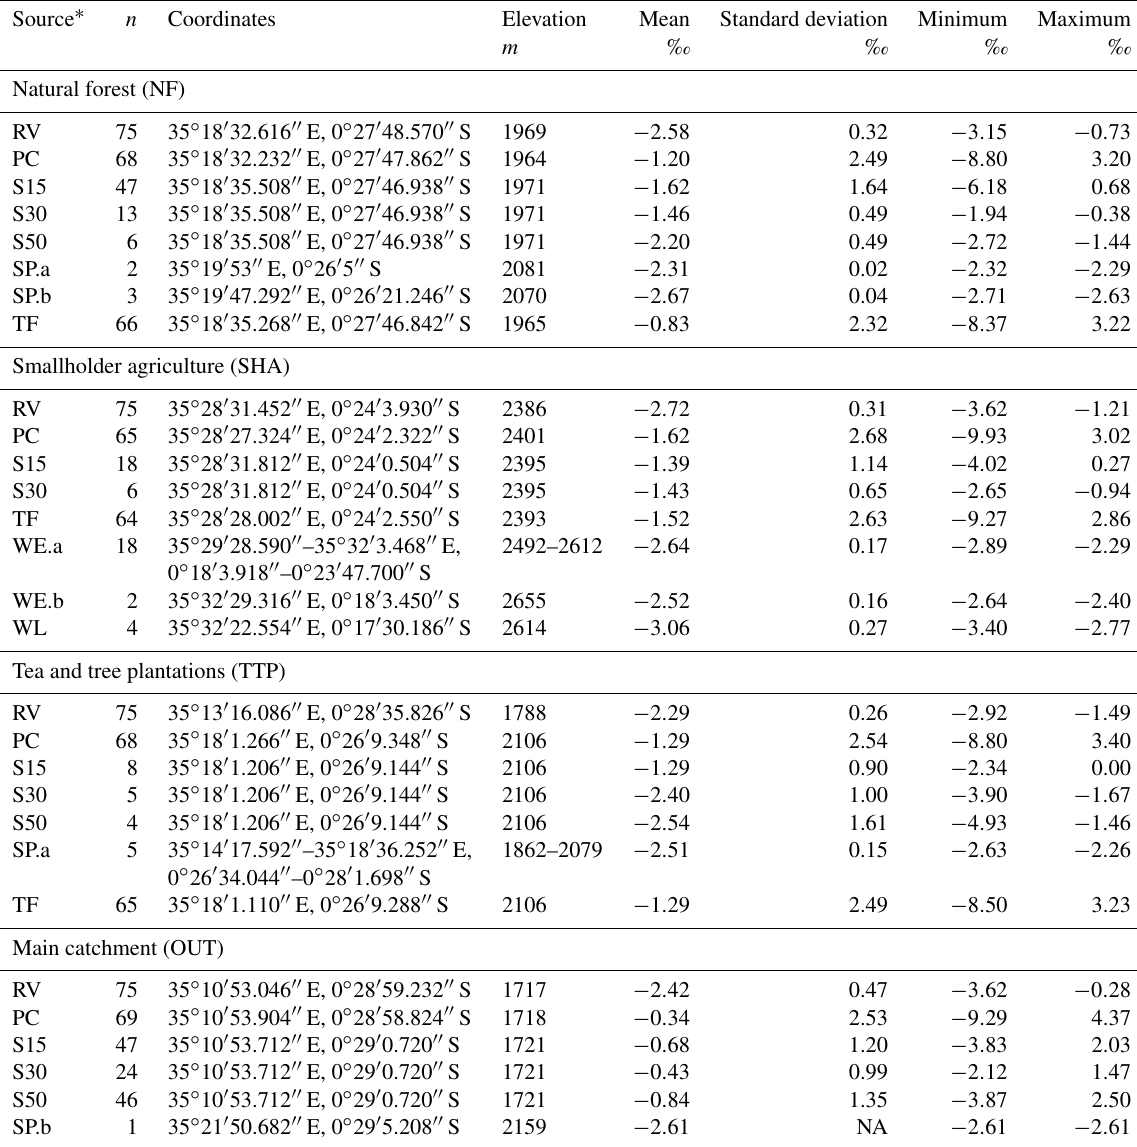
Table 4. Number of samples ( n ), coordinates, elevation, and summary statistics of δ 18 O values of samples collected at all sampling sites between 15 October 2015 and 21 October 2016 in the South-West Mau,